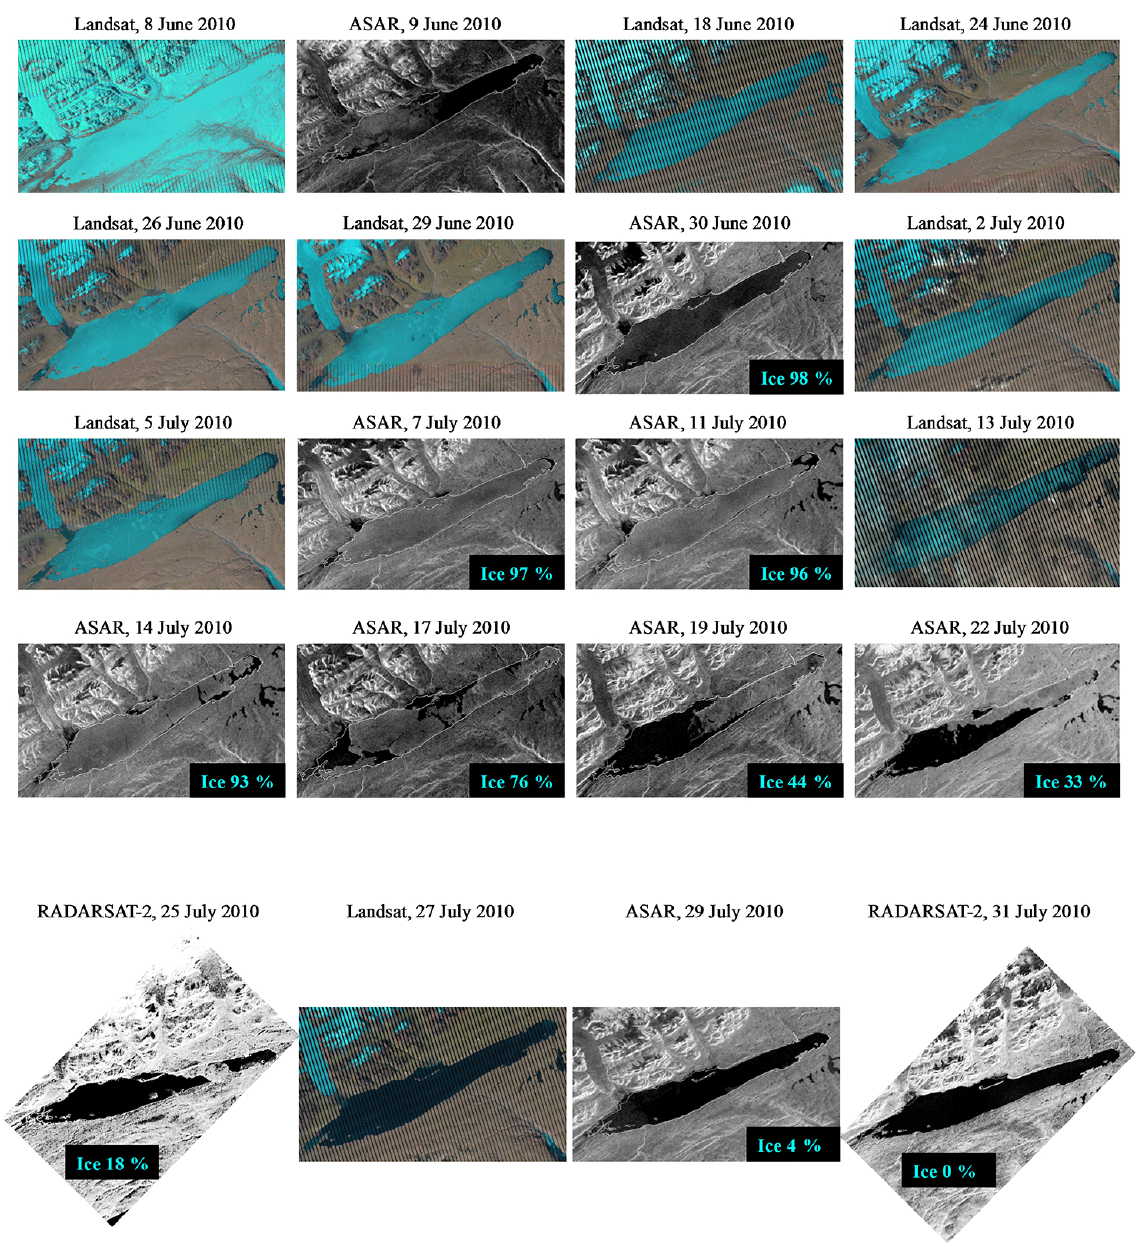
Figure 9. Time series of combined satellite observations (Landsat, ASAR, and RADARSAT-2) for Lake Hazen during the break-up period of 2010. RADARSAT-2 Data and Products © MacDonald, Dettwiler and Associates Ltd., 2010, all rights reserved. RADARSAT is an official trademark of the Canadian Space Agency. Ice fractions for available SAR images are also shown. No ice fractions are shown for Landsat observations as image segmentation was only performed on SAR